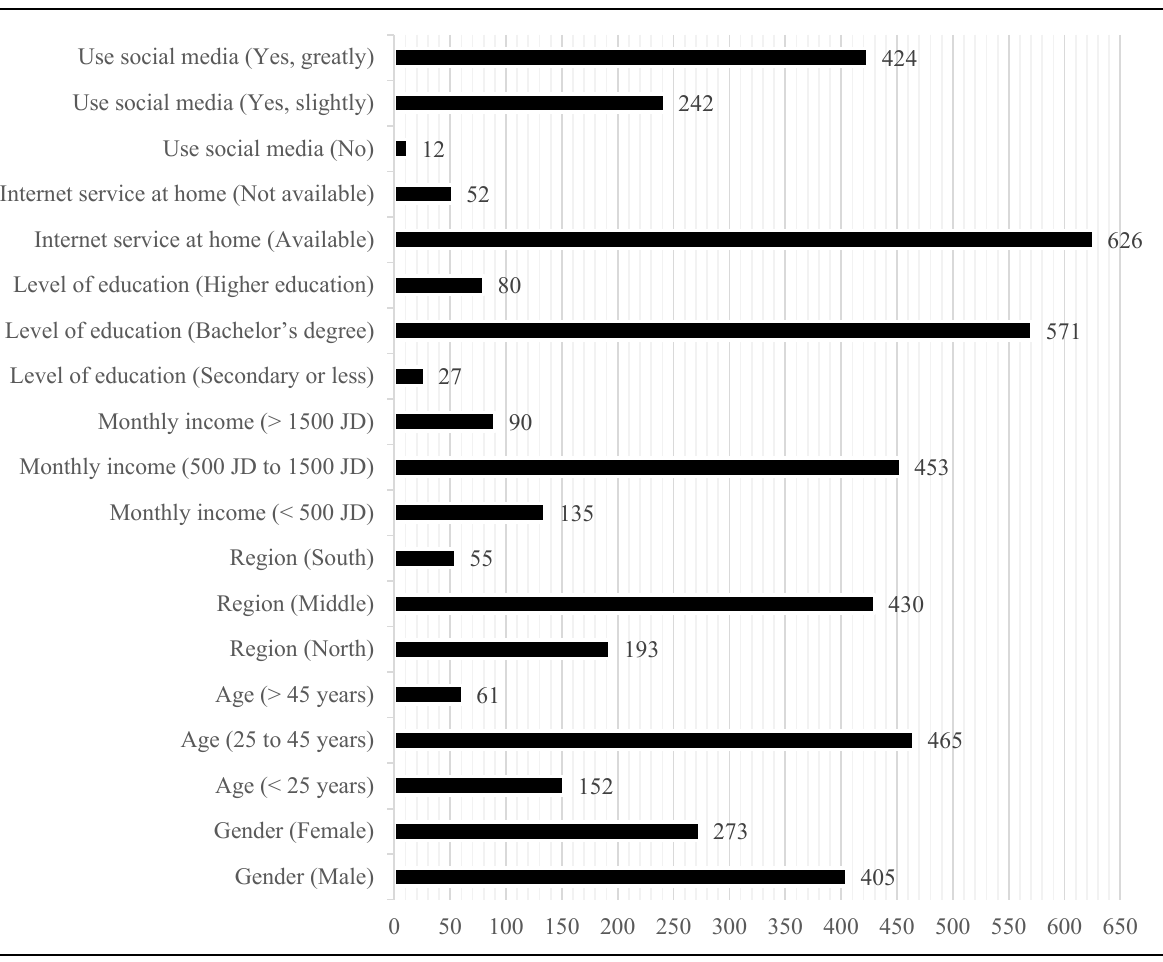
Fig. 2. Profiles of